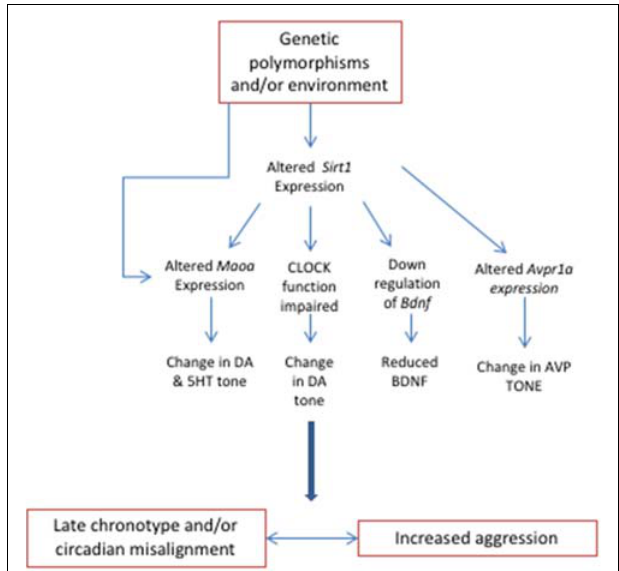
FIGURE 1 | Changes in the expression of genes involved in circadian rhythms influence aggression. The environment and/or polymorphisms in genes such as Sirt1 , Clock , and Avpr1a induce circadian misalignment, which also affects pathways that mediate aggression, such as the dopaminergic and serotonergic